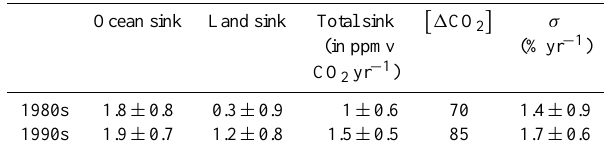
Table B1. Estimates of the annual ocean and land net sink for carbon (in PgCyr − 1 ), including those associated with land-use changes (Le Qu´er´e et al., 2003), the total sink (in ppmv CO 2 yr − 1 ), the decadal mean value of the carbon dioxide disequilibrium above 275ppmv [ 1 CO 2 ] , and the associated linear sink coefficient σ (%yr − 1 ). For convenience, the total sink is expressed in units of ppmv atmospheric CO 2 per year through division by the total at- mospheric mass (Trenberth, 1981), such that 1ppmv CO 2 =2.13Pg emitted carbon.